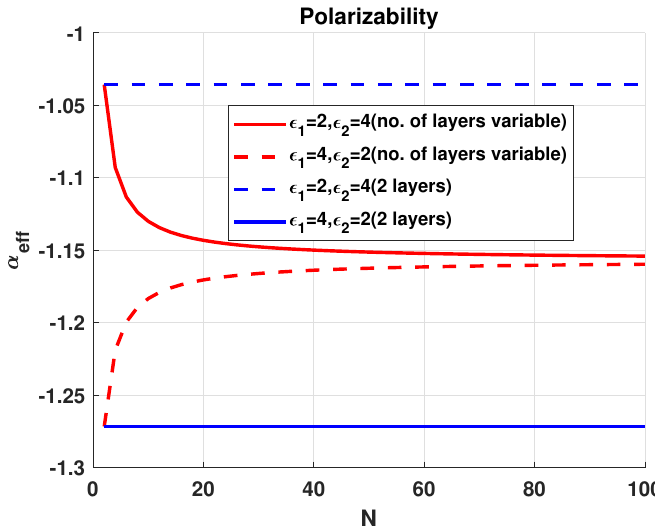
Figure 3. Normalized polarizability of the isotropic multilayer sphere as a function of the N number of layers, with the following parameters: ε 1 = 2; ε 2 = 4; ν 1 = 1 and ν 2 = 1.